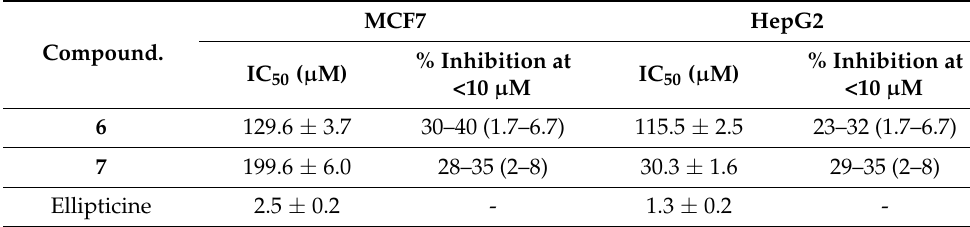
Table 2. Anticancer activity of compounds 6 and 7 . MTT cancer cells antiproliferation assay was done using reported protocols from literature [10,11]. The values are means of triplicate experiments. Incubation time was 72